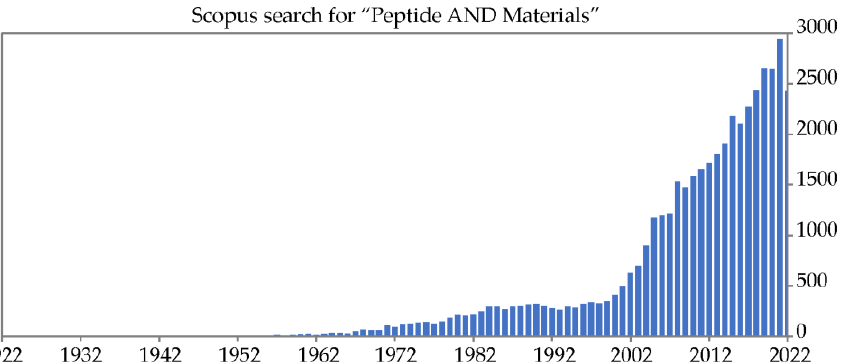
Figure 1. Number of publications in the last century present on Scopus containing “peptide